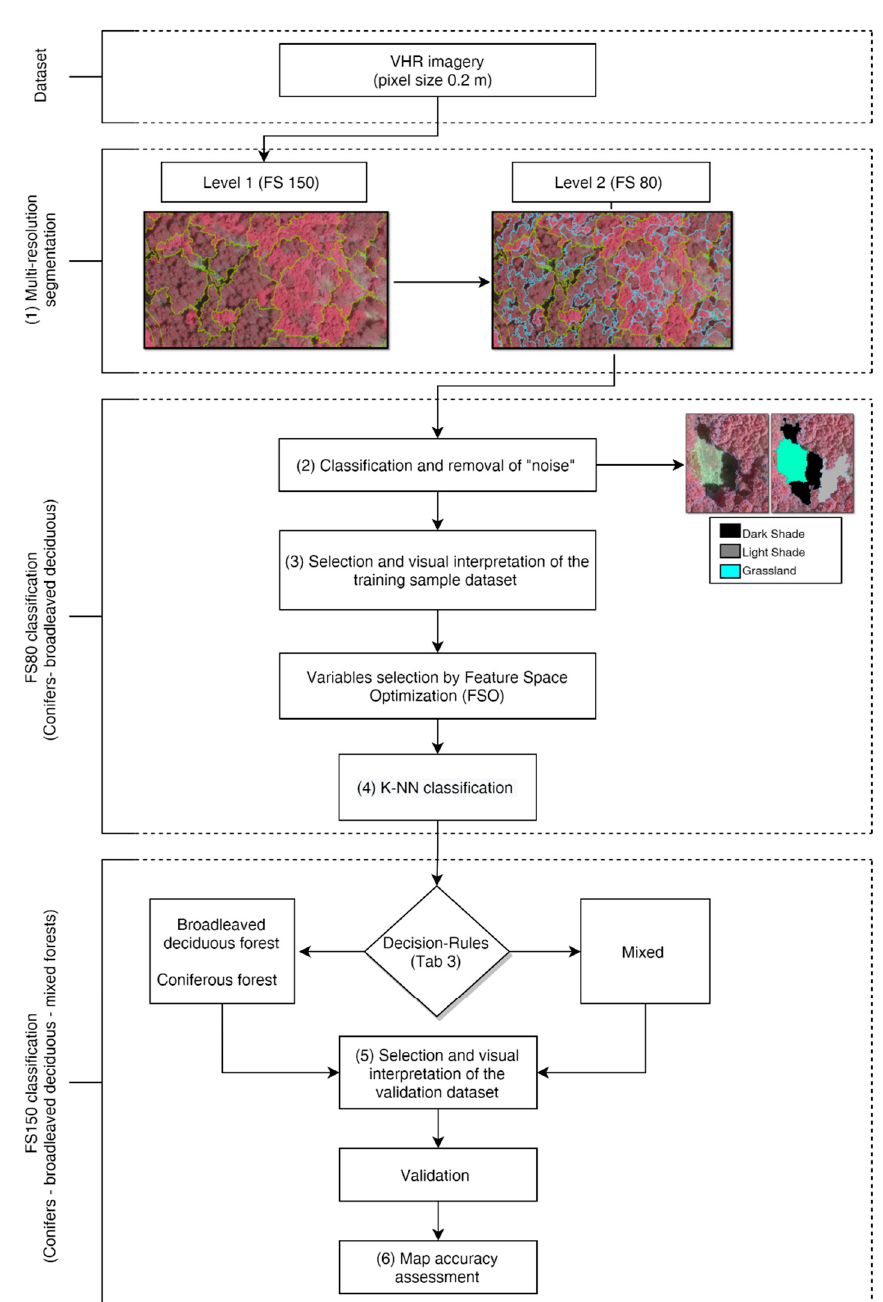
Figure 2. Overview of the image processing flow.